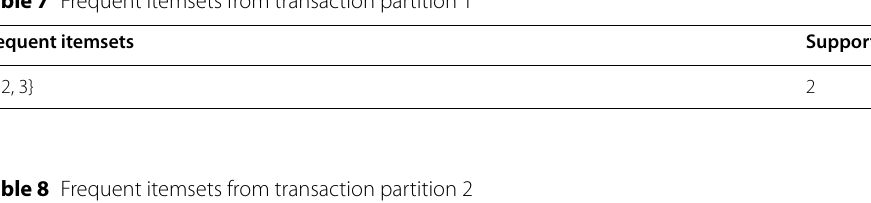
Table 8 Frequent itemsets from transaction partition 2 Frequent itemsets